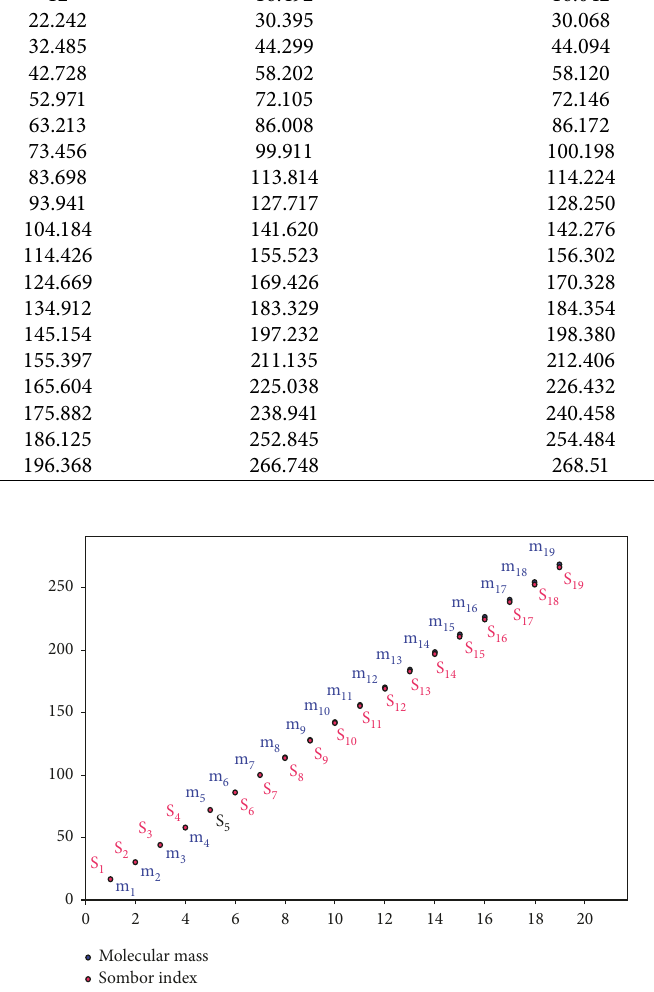
Figure 3: Sombor index and molecular mass of the first nineteen alkanes. Table 2: Sombor index and molecular mass of some annulenes ( n � odd ≥